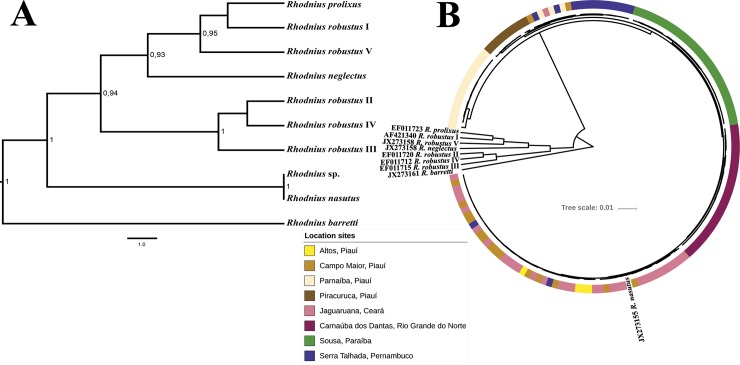
A–Maximum clade credibility species tree reconstructed with 595-bp cyt b sequences of 156 Rhodnius specimens. Posterior probabilities above 0.95 are show for key nodes. B–Coalescent gene tree with 147 sequences of 595-bp cyt b. GenBank accession numbers of R. nasutus sequenced in this study are MG734978-MG735124. The accession numbers of the sequences retrieved from GenBank are shown on the tips of their respective tree stems.